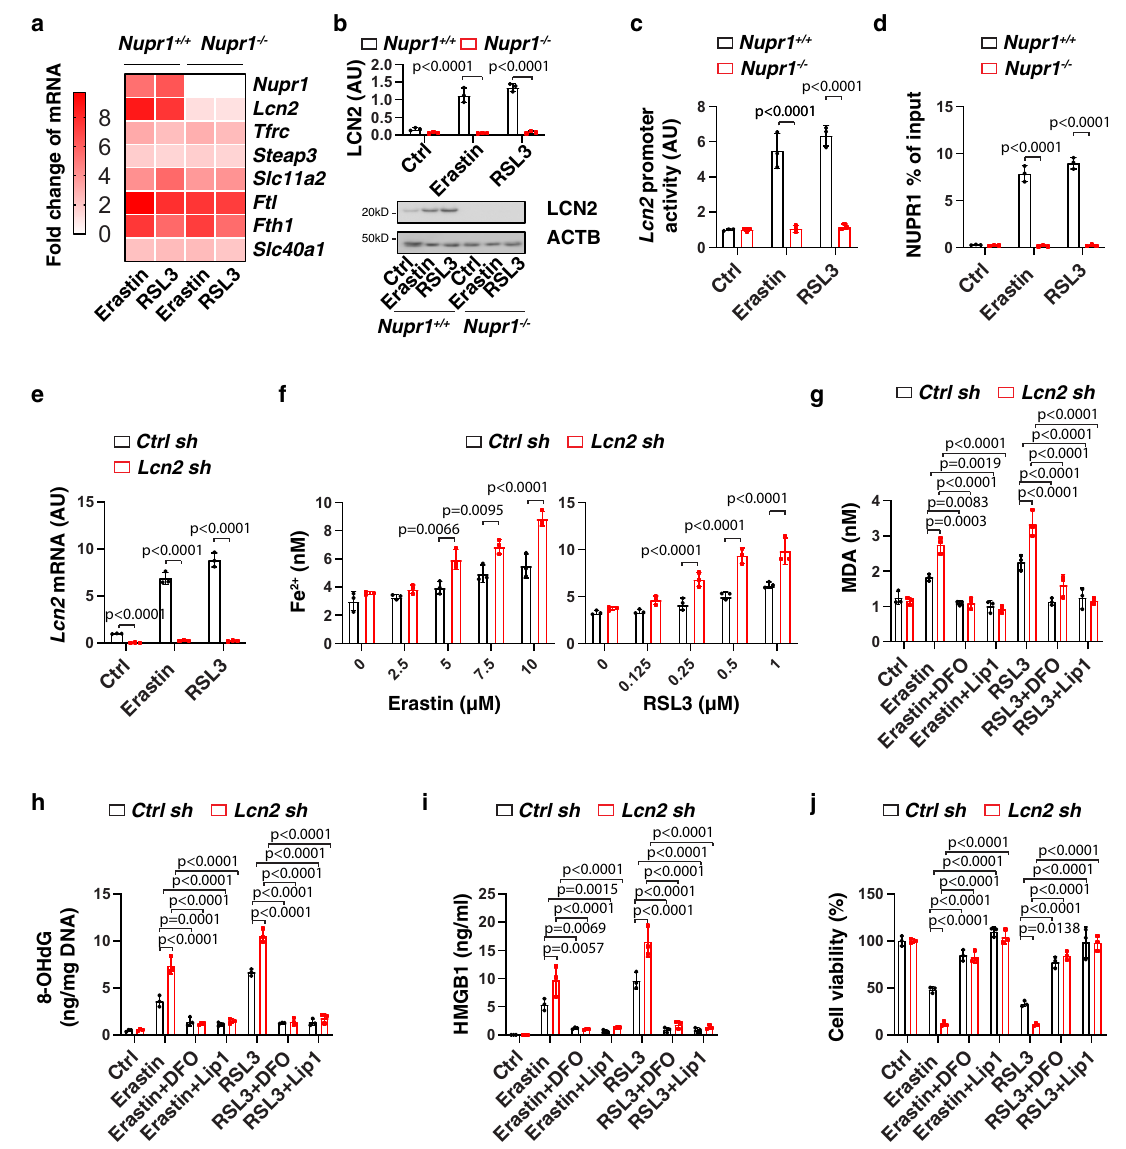
Fig. 3 LCN2 acts as an effector gene of NUPR1 in blocking ferroptosis. a Heatmap of relative mRNA levels of iron metabolism-associated genes in Nupr1 + / + and Nupr1 − / − mPDAC cells following treatment with erastin (10 µ M) or RSL3 (1 µ M) for 24 h. b , c Analysis of LCN2 protein expression and Lcn2 promoter activity in Nupr1 + / + and Nupr1 − / − mPDAC cells following treatment with erastin (10 µ M) or RSL3 (1 µ M) for 24 h ( n = 3 well/group, one-tailed t test). d Binding of NUPR1 to Lcn2 promoter was analyzed using ChIP-qPCR in indicated mPDAC cells following treatment with erastin (10 µ M) or RSL3 (1 µ M) for 24 h ( n = 3 well/group, one-tailed t test). e qPCR analysis of Lcn2 mRNA in indicated mPDAC cells following treatment with erastin (10 µ M) or RSL3 (1 µ M) for 24 h ( n = 3 well/group, one-tailed t test). f Fe 2 + levels in indicated mPDAC cells following treatment with erastin or RSL3 for 24 h ( n = 3 well/group, two-way ANOVA with Tukey ’ s multiple comparisons test on all pairwise combinations). g – j Indicated mPDAC cells were treated with erastin (10 µ M) or RSL3 (1 µ M) in the absence or presence of DFO (100 µ M) or liproxstatin-1 (1 µ M) for 24 h, and then intracellular MDA ( g ), intracellular 8-OHdG ( h ), extracellular HMGB1 ( i ), and cell viability ( j ) were quanti fi ed ( n = 3 well/group, two-way ANOVA with Tukey ’ s multiple comparisons test on all pairwise combinations). Data in b – j are presented as mean ± SD. The results in a – j are representative of those from 2 to 3 independent experiments with three technical replicates